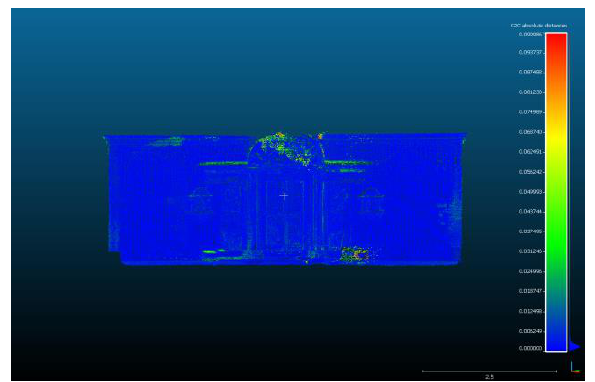
Figure 7. Dispersion results in photogrammetric point cloud compared to laser scanning point